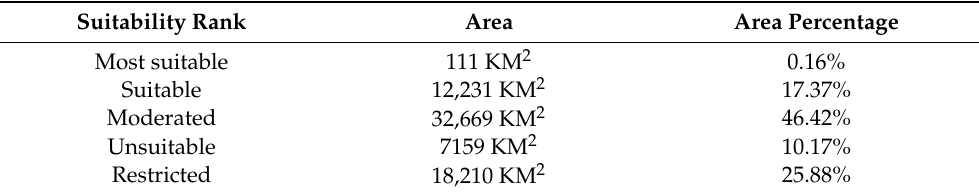
Table 7. The suitability ranked zones, their areas and area percentages. Suitability Rank Area Area Percentage Most